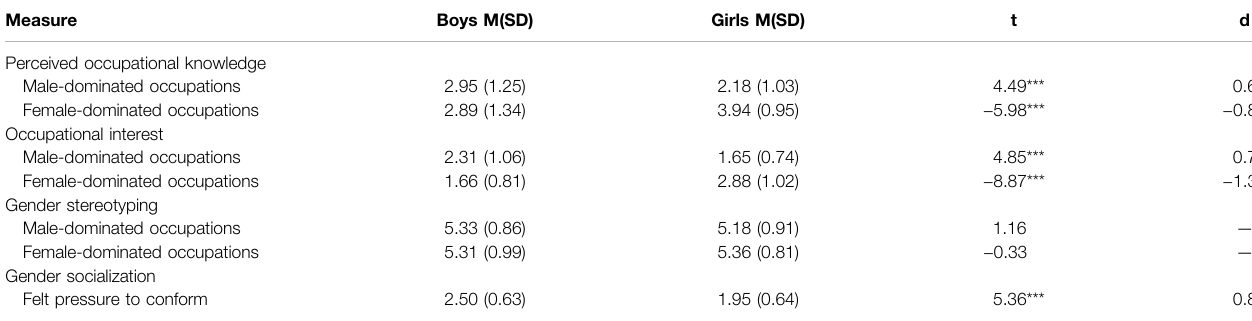
TABLE 2 | Mean gender differences in measures.